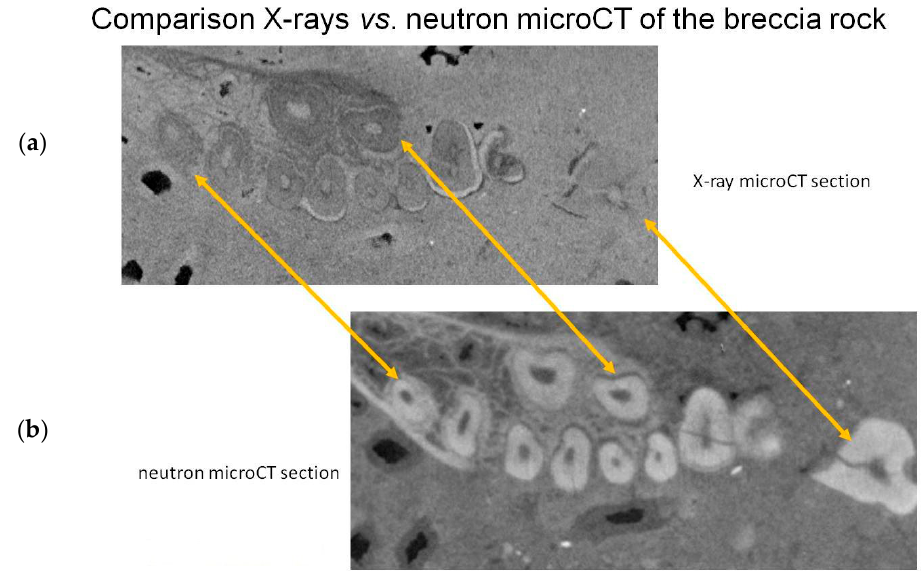
Figure 4. ( a,b ) X-ray computed tomography (CT) and neutron computed tomography (N-CT) of the rock (Beaudet et al. 2016 [8], with permission).